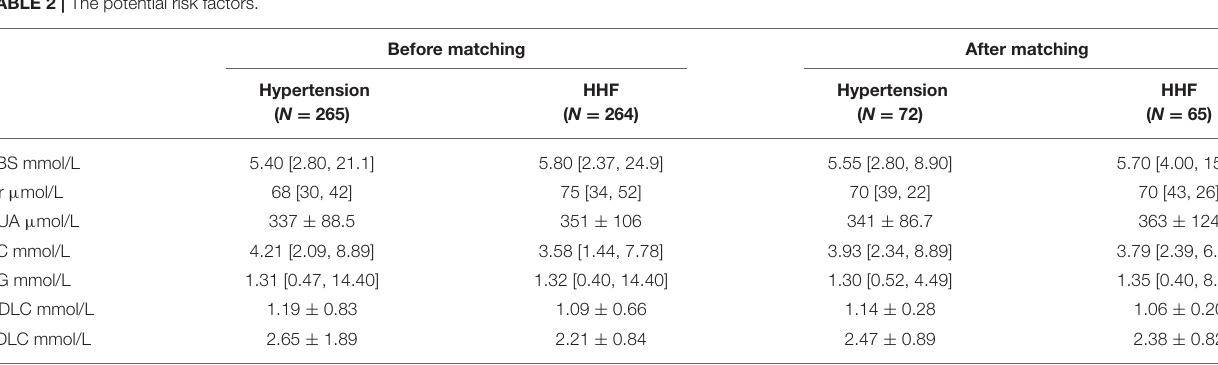
TABLE 2 | The potential risk